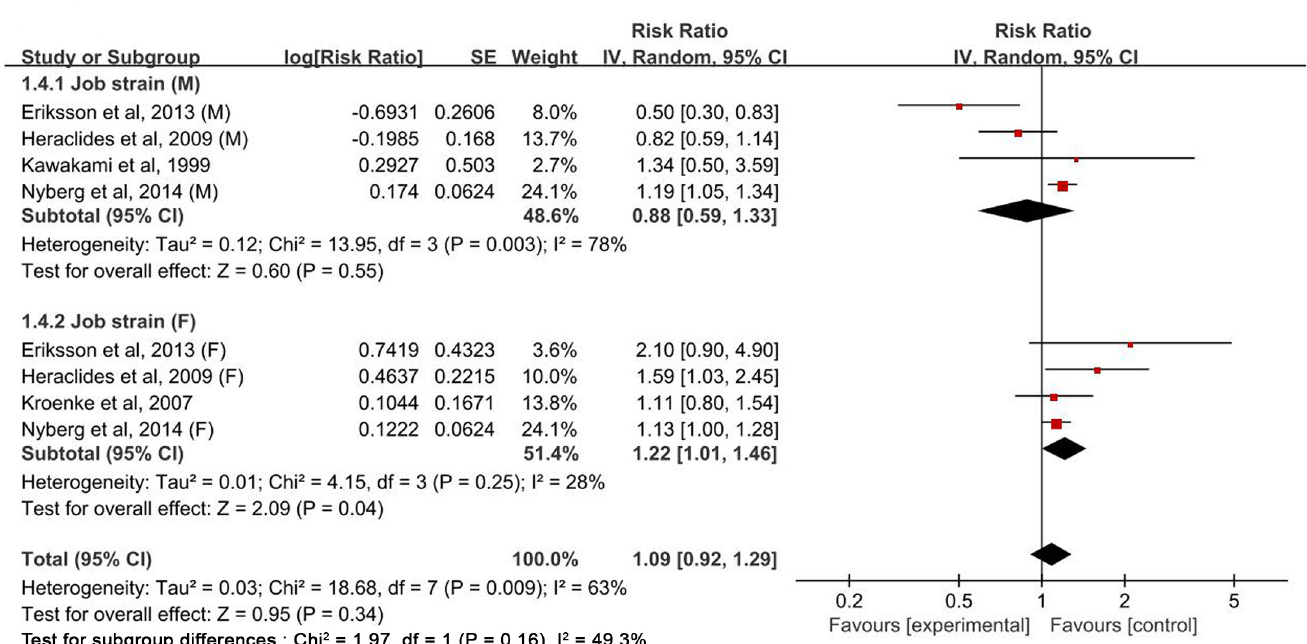
Fig 5. Estimates of type 2 diabetes associated with job strain in men and women. SE, standard error; CI, confidence interval; M, male; F, female. doi:10.1371/journal.pone.0159978.g005 Table 2). Sensitivity analyses evaluating the robustness of the association by sequentially omit- ting each study yielded a narrow range of RRs, from 0.93 (0.69 – 1.27) to 0.98 (0.82 – 1.18). Decision latitude. The pooled results based on the six studies showed that the estimate of the association between decision latitude and the risk of type 2 diabetes was not significant (RR: 1.16 [0.85 – 1.58]) (Fig 2). In subgroup analyses by sex, no association was found between low decision latitude and high risk of type 2 diabetes both in women (RR: 1.64 [0.99 – 2.72]) ( P = 0.05) and men (RR: 0.88 [0.71 – 1.09]) ( P = 0.23). Statistically significant heterogeneity was observed